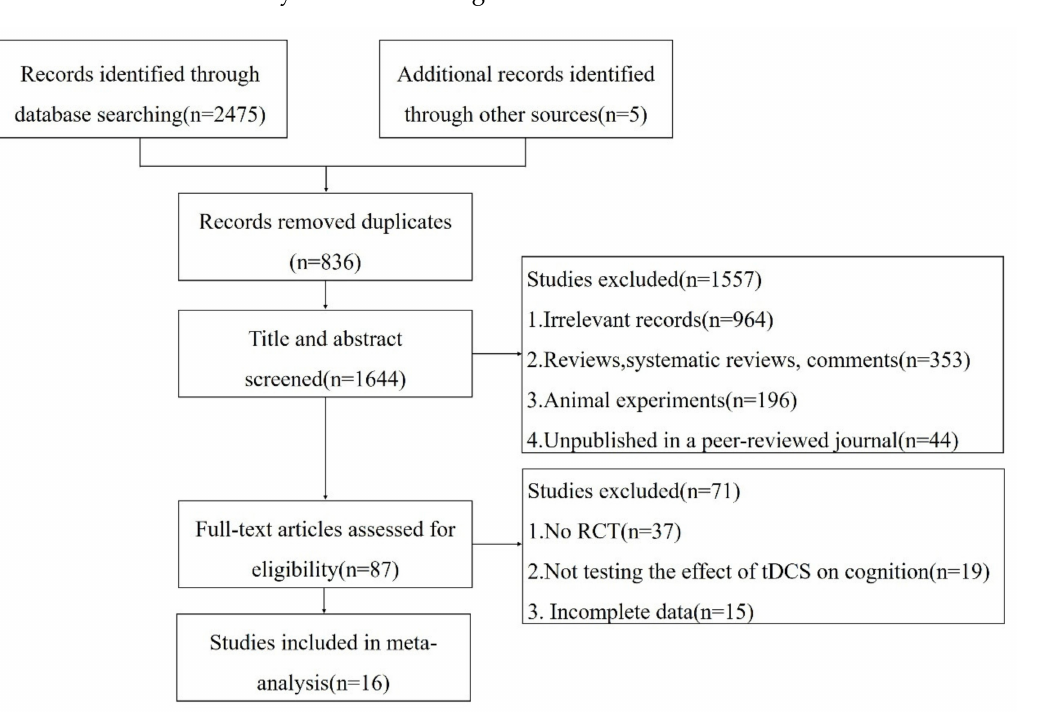
Figure 1. Flow diagram of the screening process of the